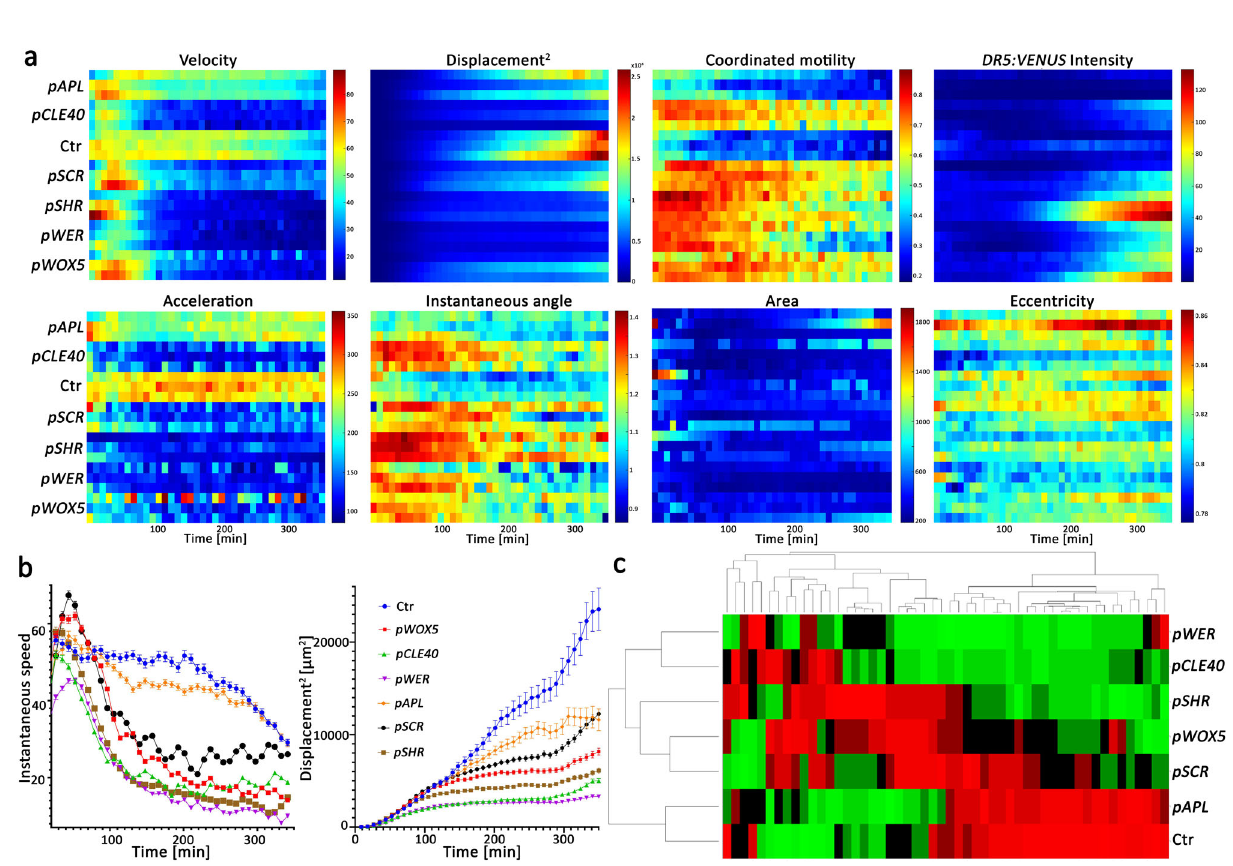
Fig. 3 Root kinetics in response to cell-type-speci fi c IAA induction. a Heat maps of 8 root kinetic and morphologic parameters in response to cell-type- speci fi c auxin production. Red indicates high and blue indicates low values. The data are average values for the different parameters collected from all root nuclei over time including meristem, elongation, and differentiation zones. Data were concatenated from three independent root movies for each line, each with ~1000 nuclei. b Instantaneous speed and cell displacement over time for the indicated lines. Shown are means (±SD), n ≥ 300. c Hierarchical clustergram analysis of the indicated lines grouped by morphokinetic parameters. Ctr indicates control mock-treated pWOX5:XVE:YUC1-TAA1; DR5:VENUS seedlings. For complete list of all parameters see Supplementary Table 1 and Supplementary Fig. 9. Data were concatenated from three independent root movies for each line, each with ~1000 nuclei. The n number for each line and time point is indicated at Source data fi le. T 0 is 20 min following 5 μ M estradiol partially repressed pWOX5:XVE:YUC1-TAA1 -dependent root